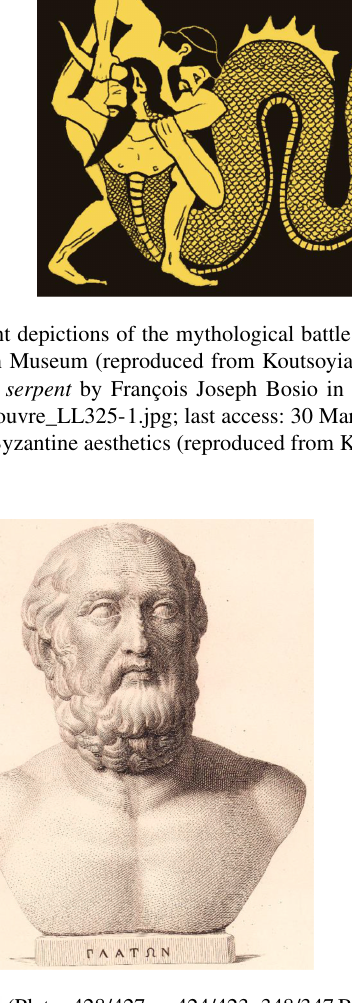
Figure 2. (Plato, 428/427 or 424/423–348/347BC), Athe- nian philosopher of the Classical period, founder of the